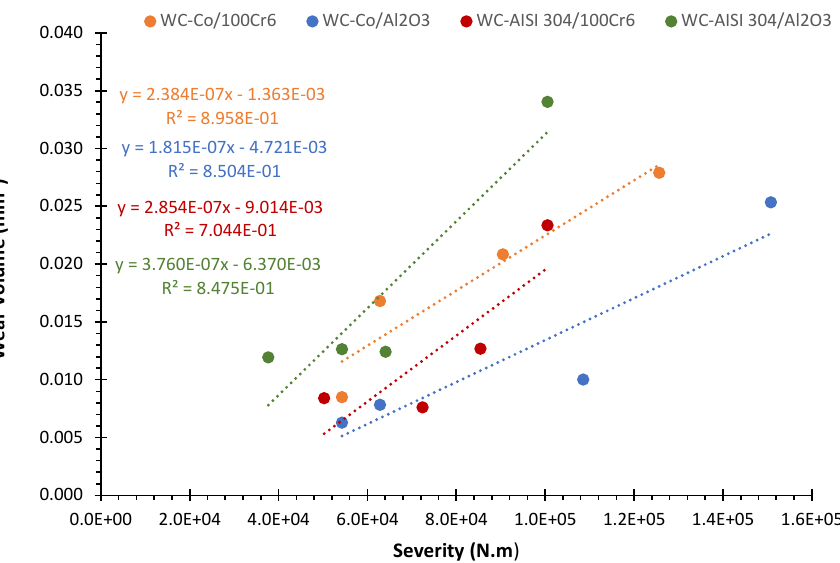
Figure 10. Disc wear coefficients for the systems: WC-Co/100Cr6, WC-Co/Al 2 O 3 , WC-AISI 304/100Cr6 and WC-AISI 304/Al 2 O 3 . To facilitate the comparison, the wear coefficients obtained for the discs of the various systems under study are shown in the graph of Figure 11.